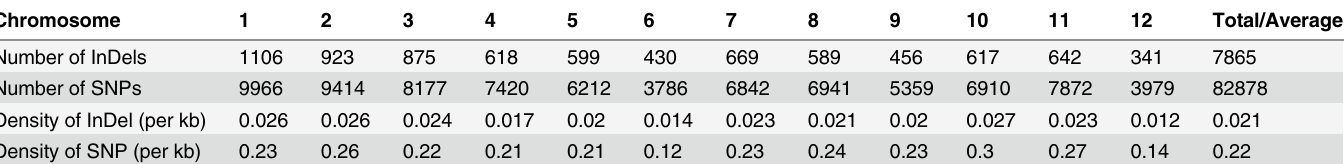
Table 1. SNP/InDel frequency detected by AMF between JP69 and Jiaoyuan5A.